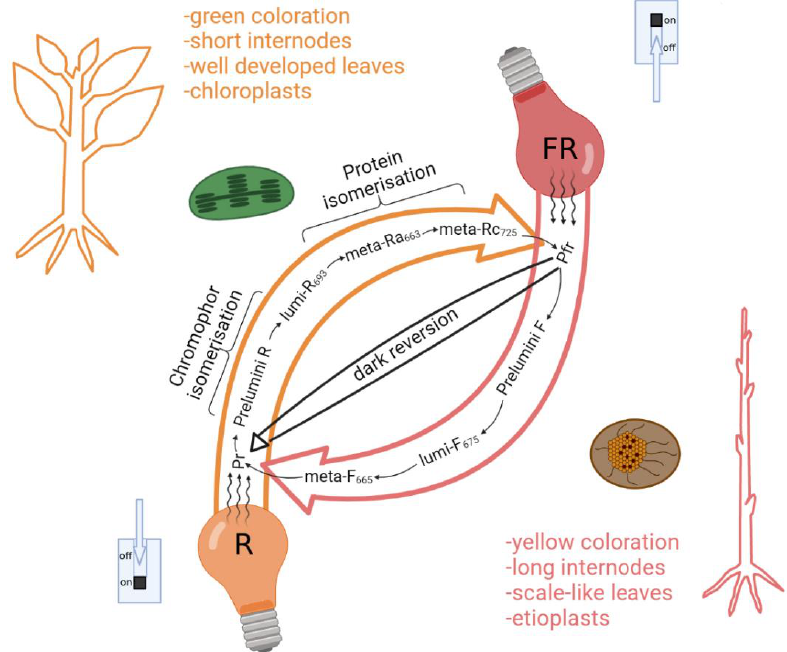
Figure 2. Photoequilibrium exchange under red and far-red radiation and its effect on plants.